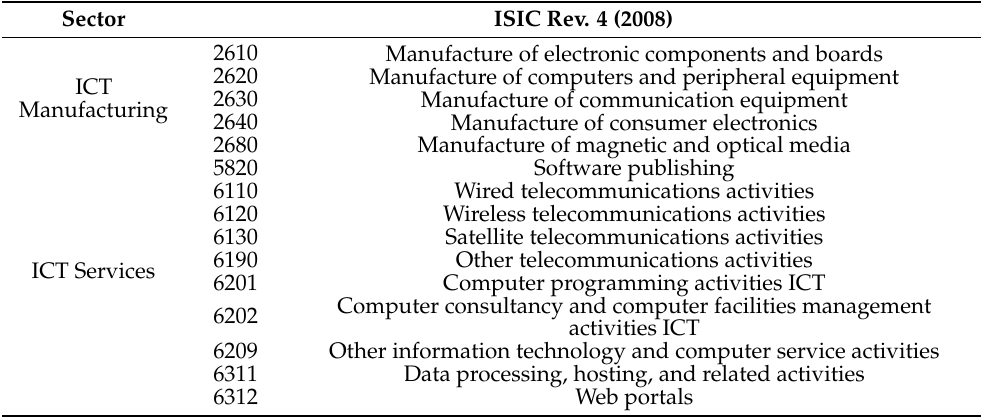
Table 4. The 2006–2007 OECD ICT sector definition (based on ISIC Rev.